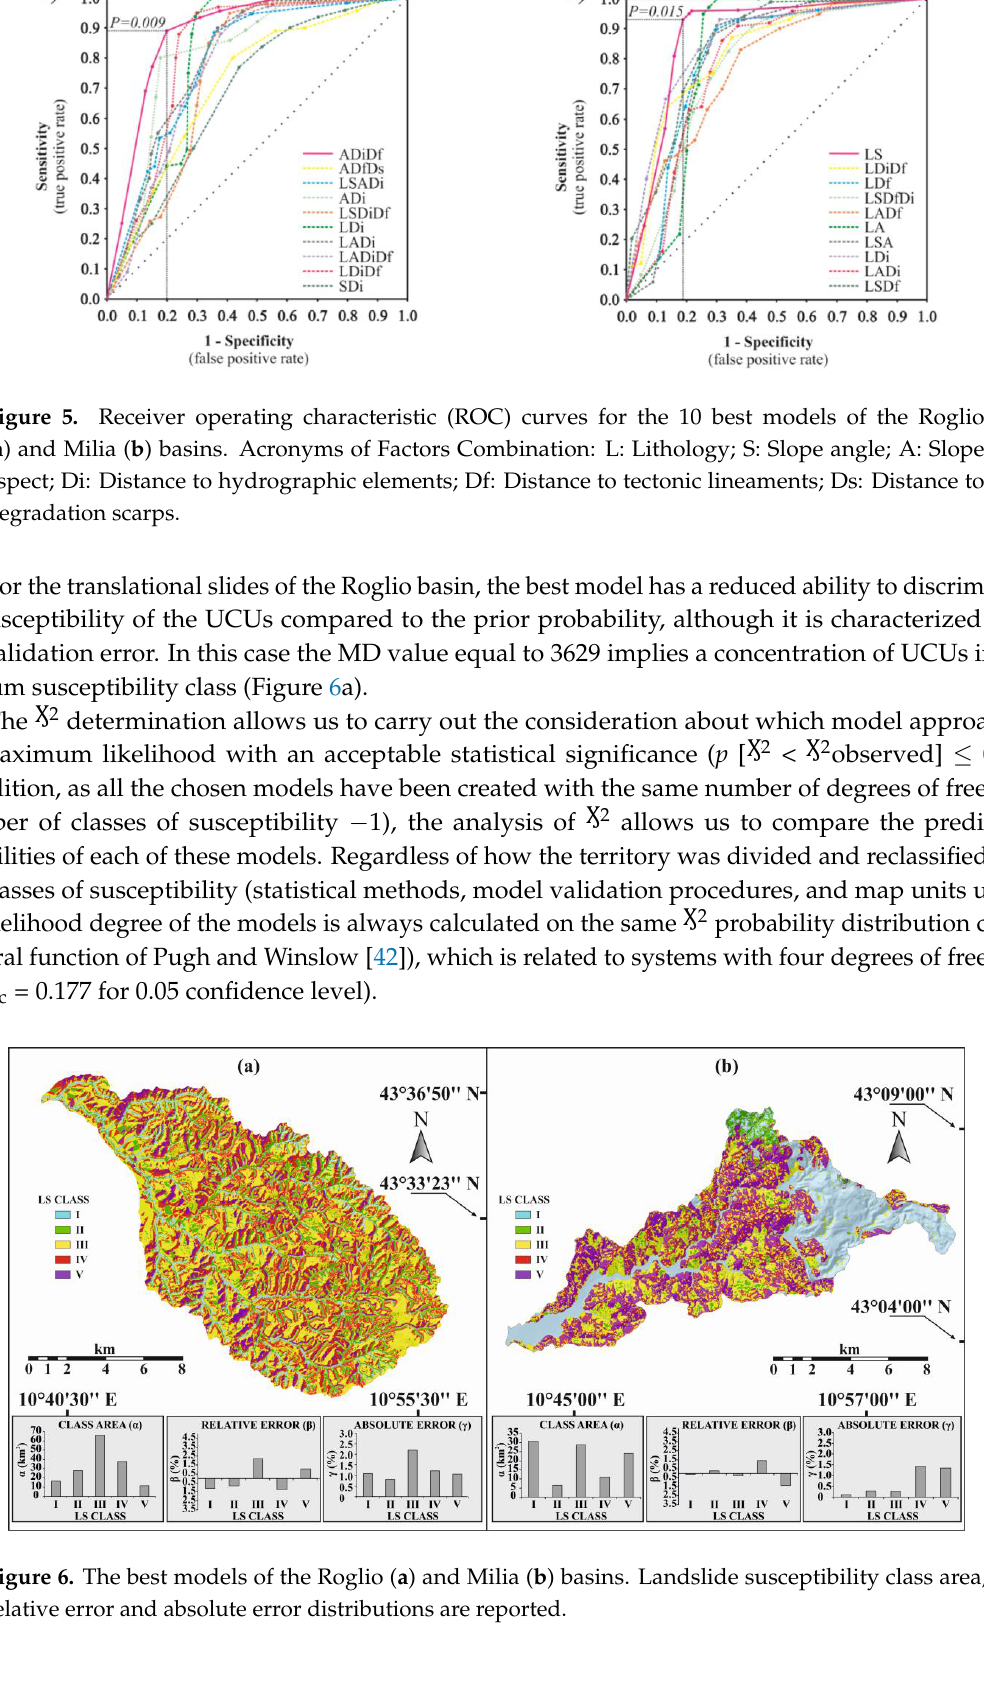
Table 2. The 10 best models of landslide susceptibility obtained for each basin. FC: Factors combination (L: Lithology, S: Slope angle, A: Slope aspect, Di: Distance to hydrographic elements, Df: Distance to tectonic lineaments, Ds: Distance to degradation scarps); VE: Validation error (%); MD: Mean deviation (m 2 /km 2 ); BMI: Best model index (km 2 /m 2 ); ROC AUC (%); Area Under the ROC Curve; ROC: receiver operating characteristic curve. ROGLIO BASIN